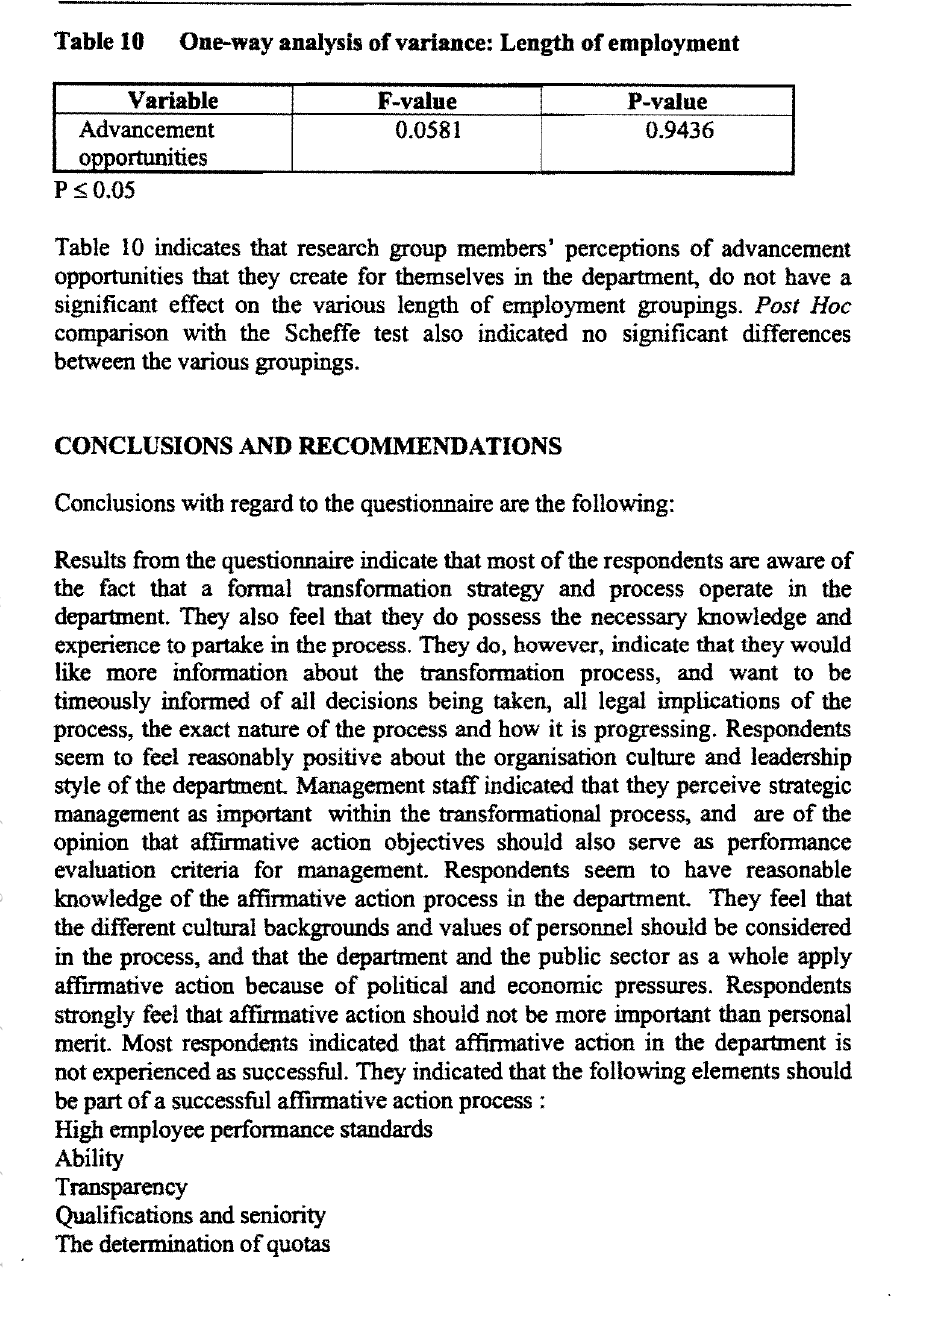
One-way analysis of varianee: Length of employment Variable